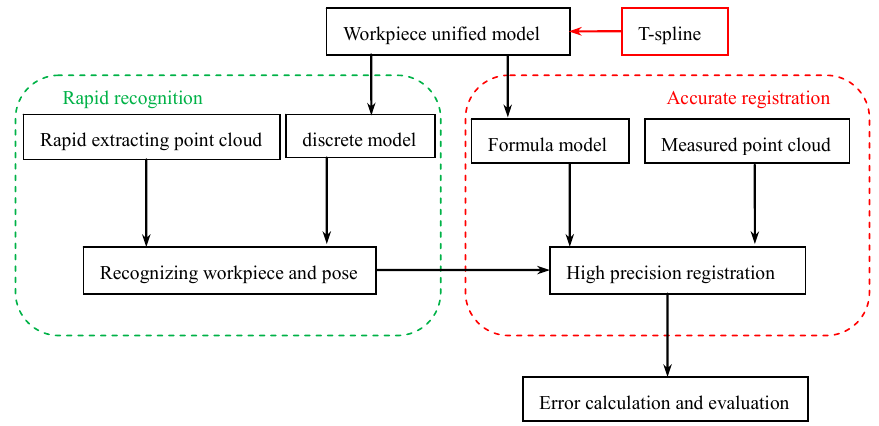
Figure 1. Diagram illustrating the coordinate measuring machine (CMM) intelligent detection system.